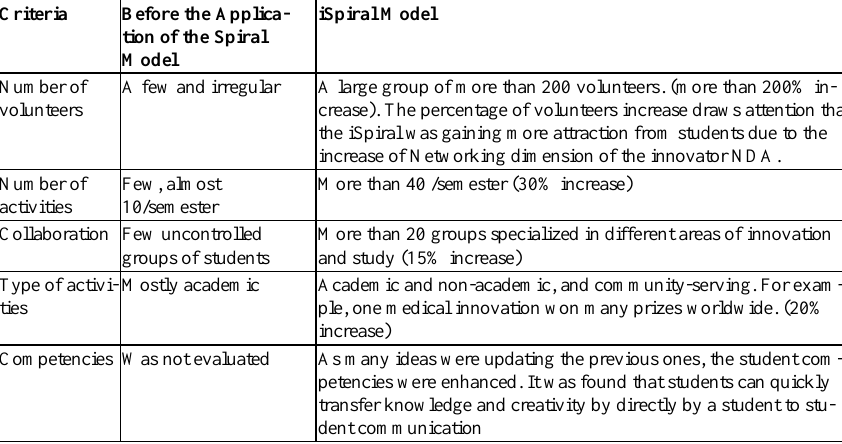
Table 4. Situation before and after applying the spiral